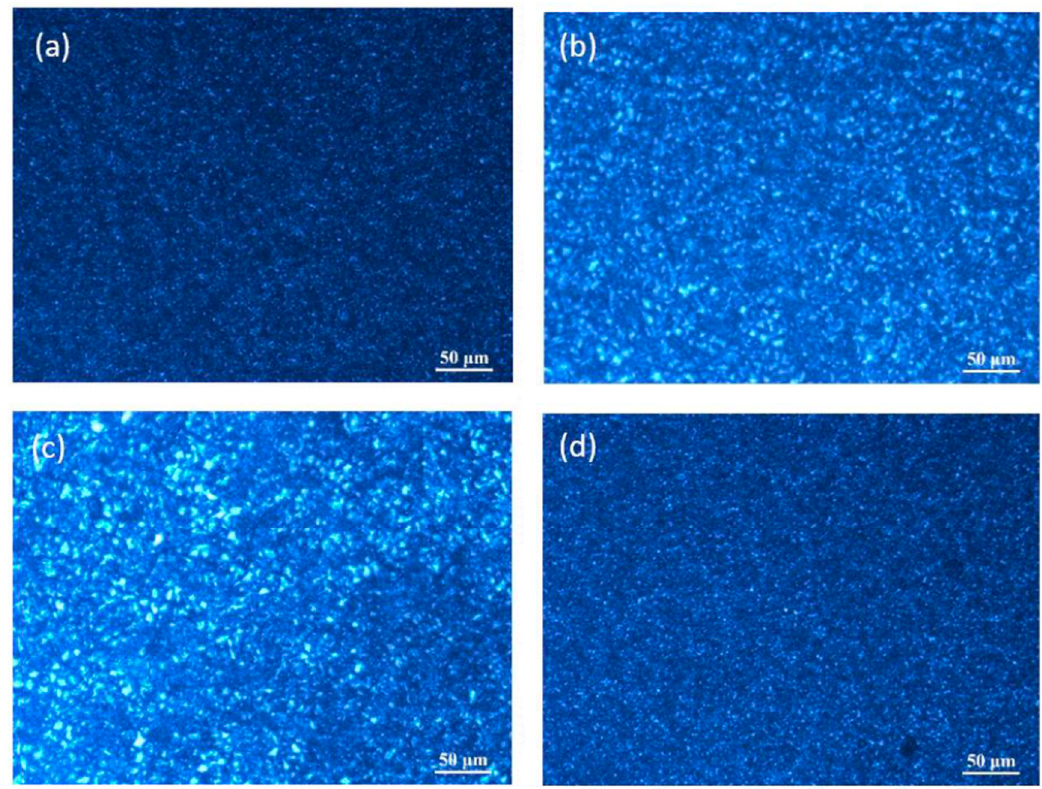
Figure 16. Polarized optical micrography (POM) micrographs of ( a ) TPAE-1000, ( b ) TPAE-1500, ( c ) TPAE-2000 and ( d ) PA10T/10I non-isothermally crystallized at 10 ◦